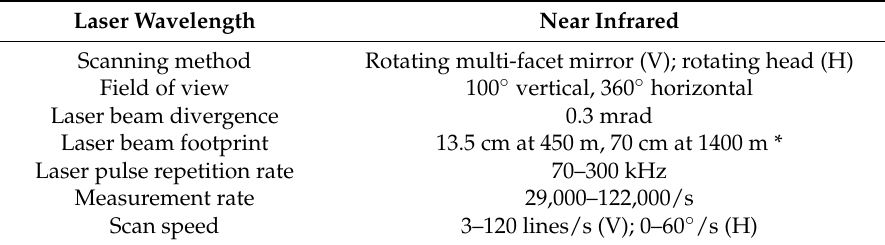
Table 1. Riegl VZ-1000 specification (source: Riegl, 2015 [54]).